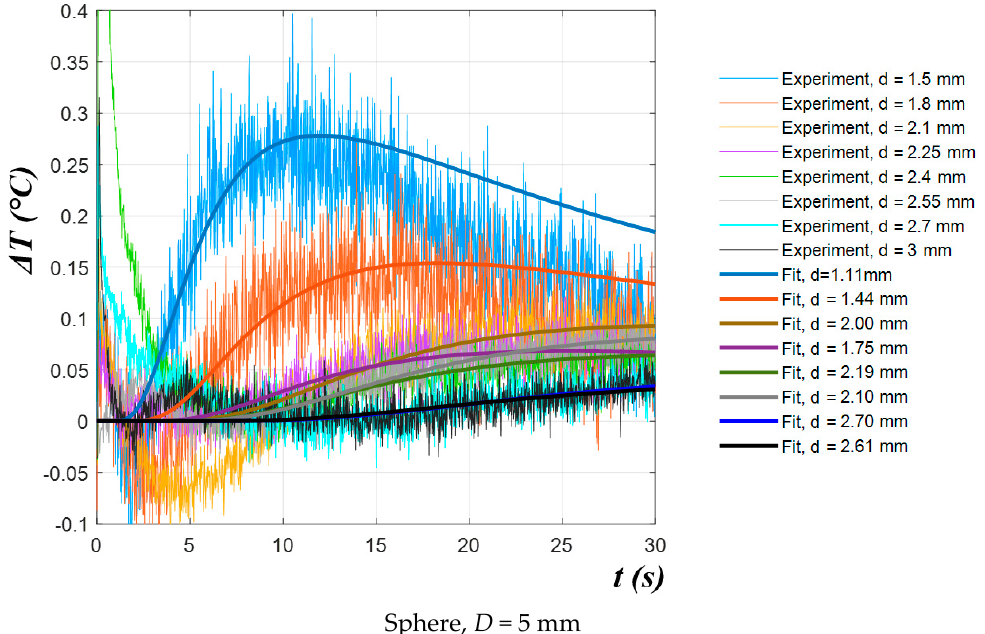
Figure 11. Experimental and fitted Δ T evolutions.